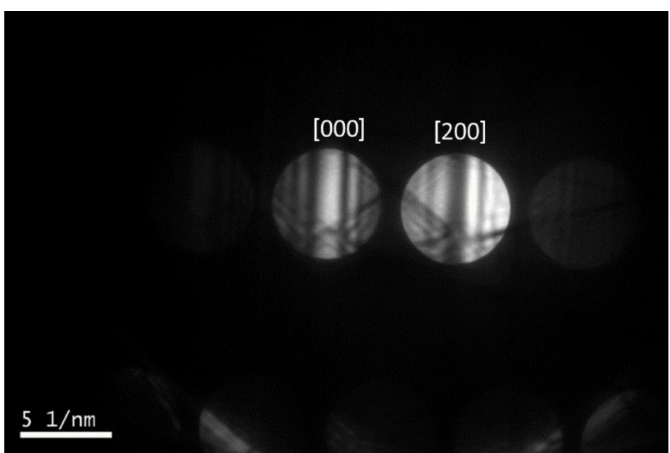
Figure 7. CBED pattern to calculate the thickness of the sample at a certain